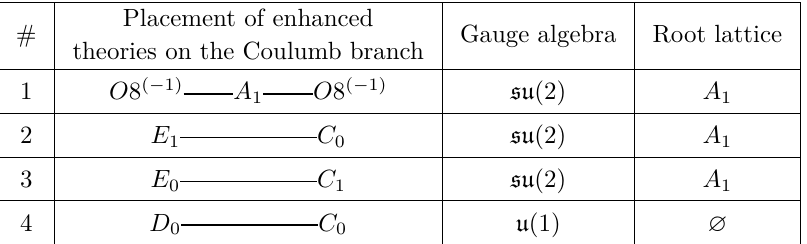
Table 4 . List of possible maximally enhanced rank 1 theories in nine dimensions which is obtained by Swampland